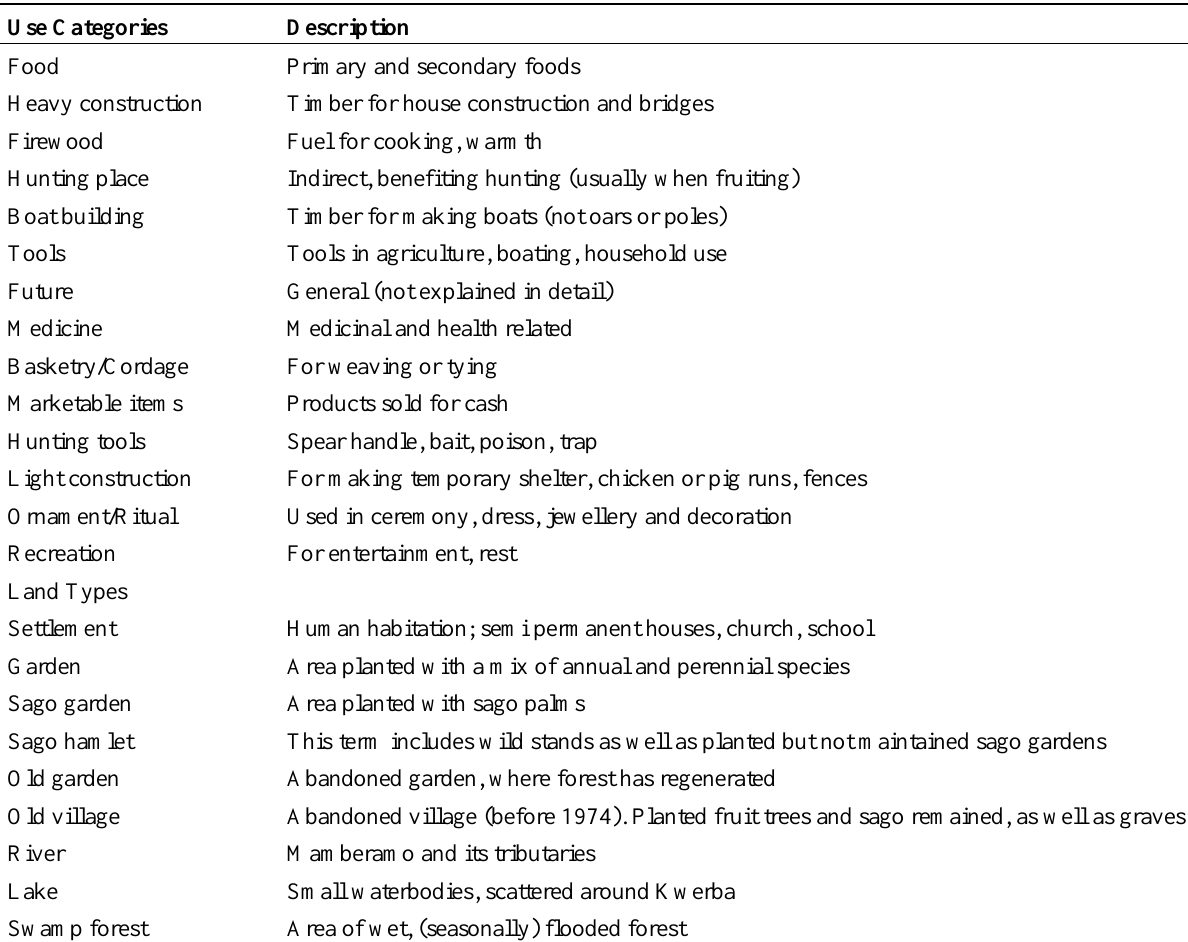
Table 2. Description of Use Categories and Land